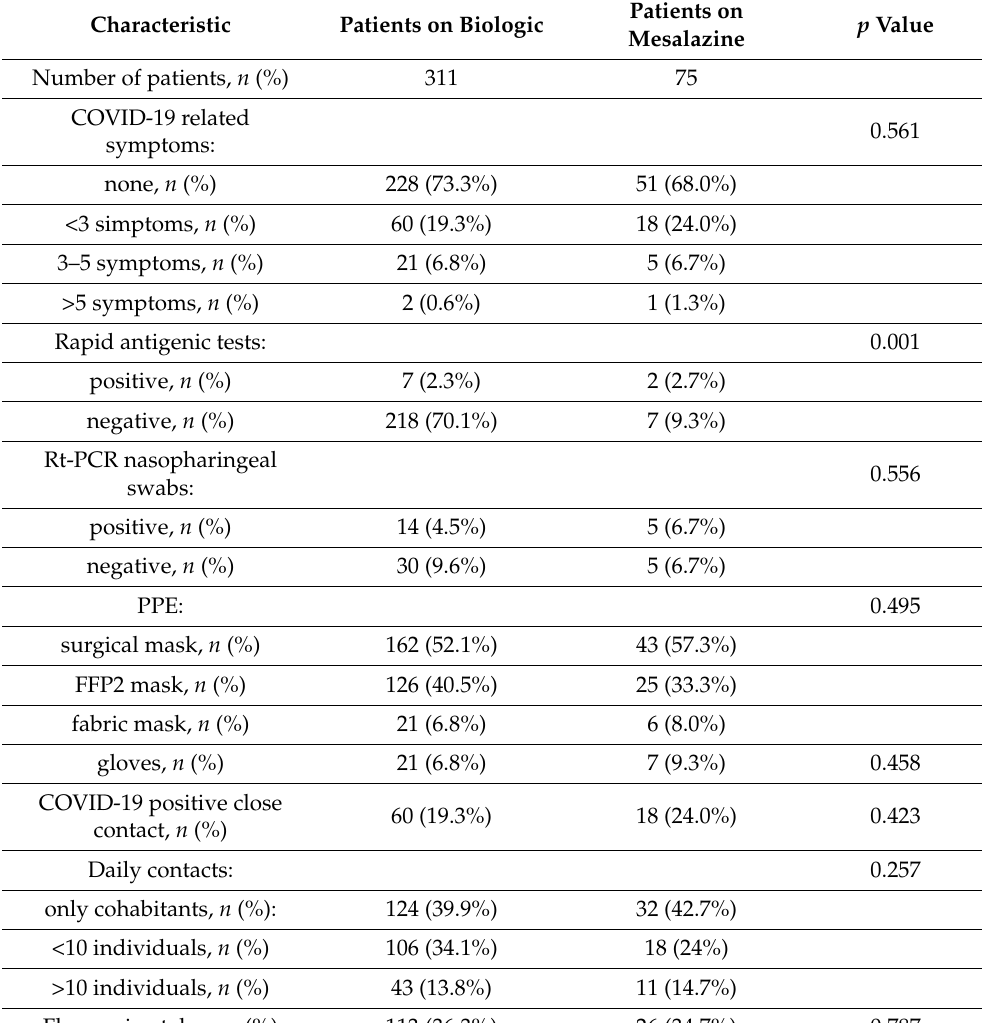
Table 2. COVID-19 related factors